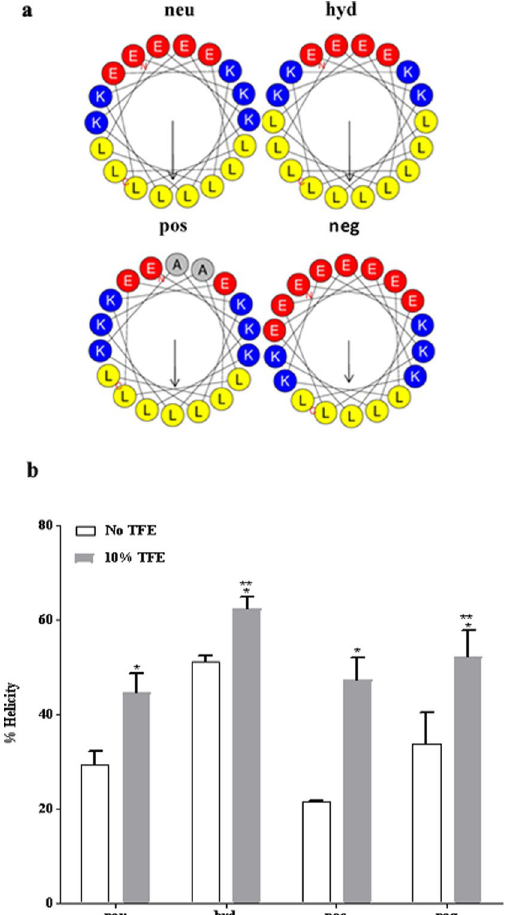
Figure 1. Physical properties of the ELKs. ( a ) Helical wheel diagrams of neu (EKLKELLEKLLEKLKELL), hyd (EKLLELLKKLLELLKELL), pos (EKLKALLEKLKAKLKELL), and neg (EELKEKLEELKEKLEEKL). Amino acids are shown as follows: Glu (E), red; Lys (K), blue; Leu (L), yellow; Ala (A), gray. Arrows are proportional to hydrophobic moments. ( b ) CD Spectroscopic analysis of the peptides. Percent helicity determined by circular dichroism (CD) spectroscopy. Measurements were carried out separately in an aqueous buffer (1% acetonitrile) plus minus TFE (10% trifluoroethanol). The mean residue ellipticity at 222 nm was used to calculate α -helicity. Statistical analysis was done using multiple t test. A global analysis for all peptides was performed in two buffer systems by using two-tailed unpaired t test. P values < 0.05 = * . Additionally, a comparison of all peptides against neu in 10% TFE was also performed using paired t test. p values are presented as p < 0.05 = ** .